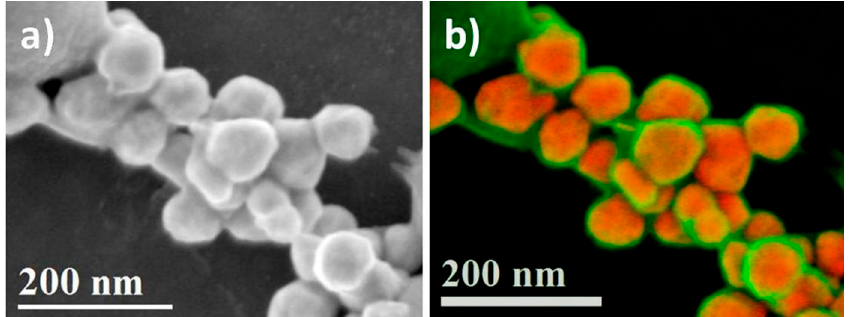
Figure 6. ( a ) SE-SEM and ( b ) BSE+SE SEM images showing the size and morphology of AuNPs synthesized with Ssp extract.